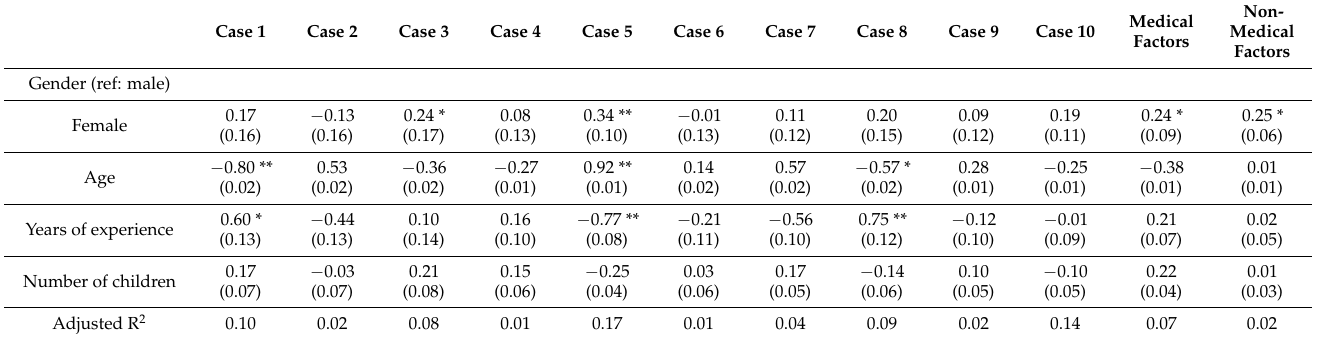
Table 2. Linear regressions with case-based scenarios as dependent